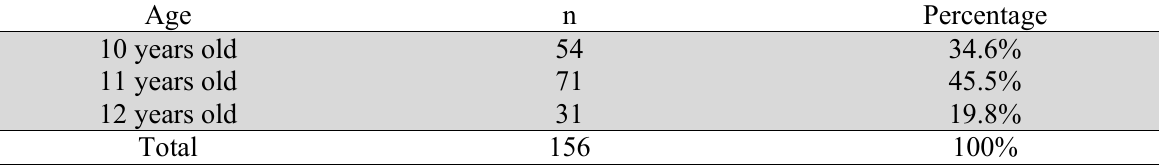
Participants description based on